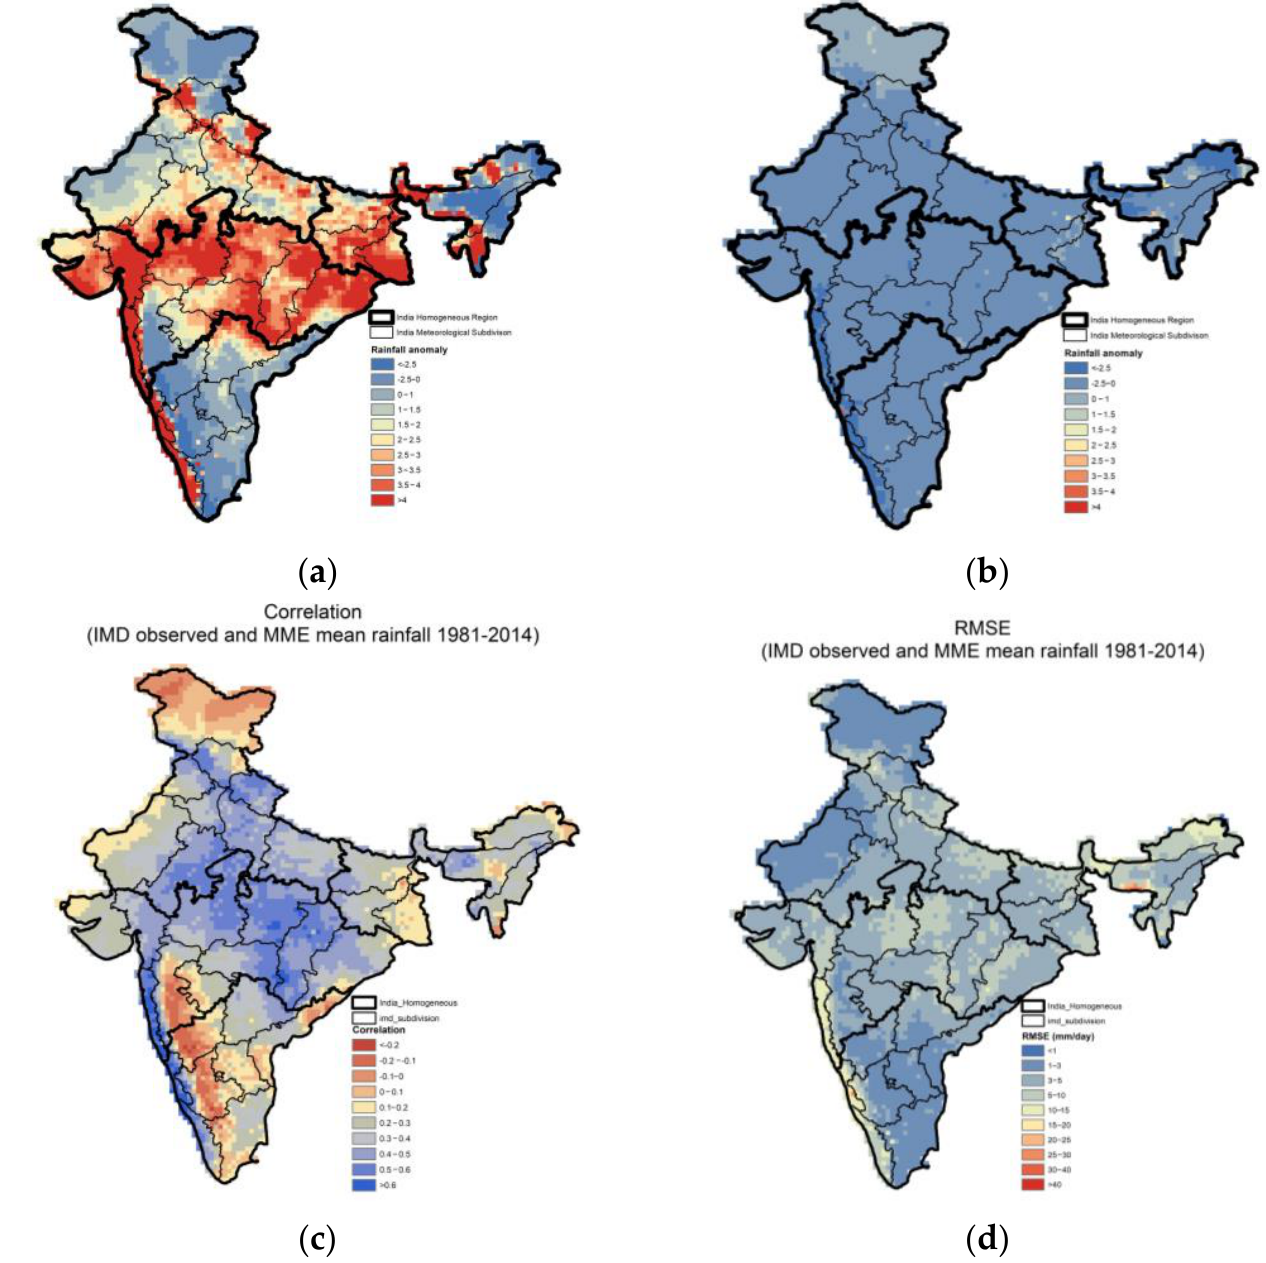
Figure 2. CMIP6 MME ensemble mean before and after EQM bias correction mean rainfall anomaly map; ( a ) before bias correction rainfall anomaly, ( b ) after bias correction rainfall anomaly, ( c ) correla- tion between IMD observed and bias-corrected CMIP6 ensemble mean rainfall (1981–2014), ( d ) RMSE between IMD observed and bias-corrected CMIP6 ensemble mean rainfall (1981 – 2014).